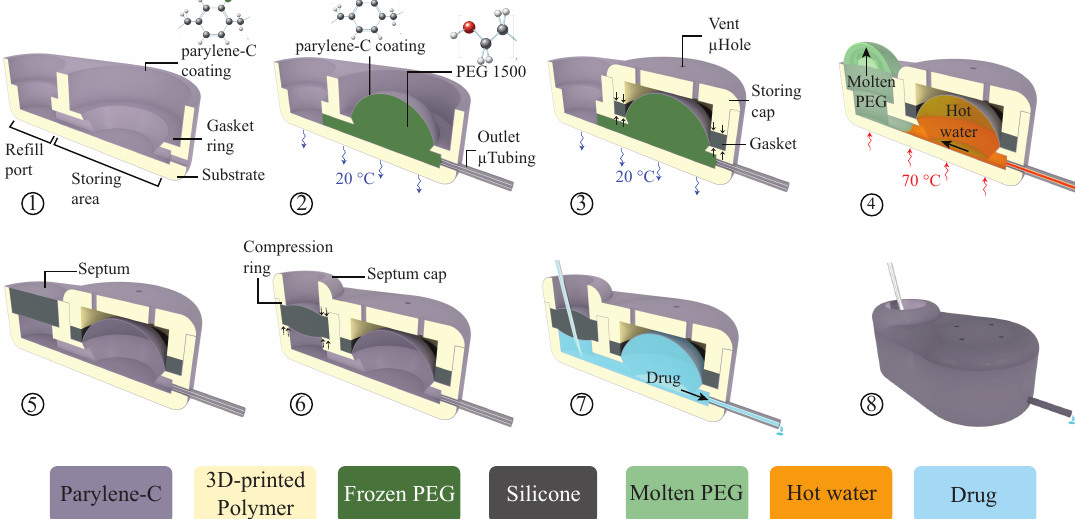
Figure 2. A cut-view schematic of the microreservoir fabrication process. (1) The substrate of the microreservoir was 3D-printed using a biocompatible resin, followed by 1 µ m parylene-C deposition. (2) A microtubing (250 µ m OD, 125 µ m ID) was inserted into the substrate outlet port and sealed in place with cyanoacrylate. The substrate was held at room temperature, and molten polyethylene glycol (PEG) at 70 ◦ C was deposited on the storing area to solidify and create the microreservoir volume. This was followed by another parylene-C deposition to form the storing membrane capable of withstanding 100 kPa backpressure. (3) A silicone gasket was fabricated using a micro-molding technique and was placed on the gasket ring. A 3D-printed parylene-C-coated cap (storing cap) was a ffi xed on top of the storing area with cyanoacrylate, compressing the O-ring to reinforce sealing between the two parylene-C layers, and to protect the storing membrane from mechanical stress. The storing cap has vent microholes to allow egress / ingress of air or fluid between the membrane and the cap during filling / discharging. (4) The substrate was placed on a hotplate at 70 ◦ C to melt the PEG and wash it by gentle injection of 100 mL of deionized water at 70 ◦ C (5) A 2.5-mm diameter, 1-mm-thick septum made of long-term implantable silicone rubber was micro-molded and coated with parylene-C. The septum was placed in the refill port (2.5 mm diameter). (6) A 3D-printed, parylene-C-coated septum cap with a raised compression ring (2.5 mm OD, 1.8 mm ID) was a ffi xed on top of the septum with cyanoacrylate to compress the septum improving sealing and self-healing. (7) Schematic cut view of the fabricated microreservoir being filled by a refill needle. (8) A schematic full-body view of the